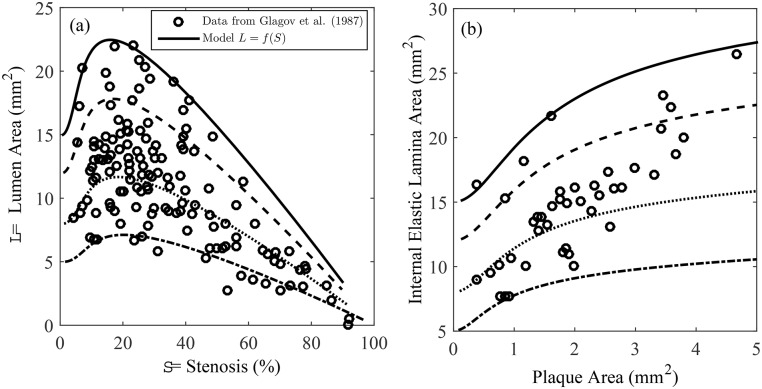
Comparison of model results to Glagov’s data.(a) Data from Glagov’s paper of lumen area L versus stenosis fraction S. Superimposed are solid curves L = f(S), generated by our model initialized with reference lumen areas πa(0)2 = πA2 = 5 (dash-dotted), 8 (dotted), 12 (dashed) and 15 (solid) mm2. (b) Data and model prediction of the internal elastic lamina area πb2 as a function of plaque area π(b2 − a2).